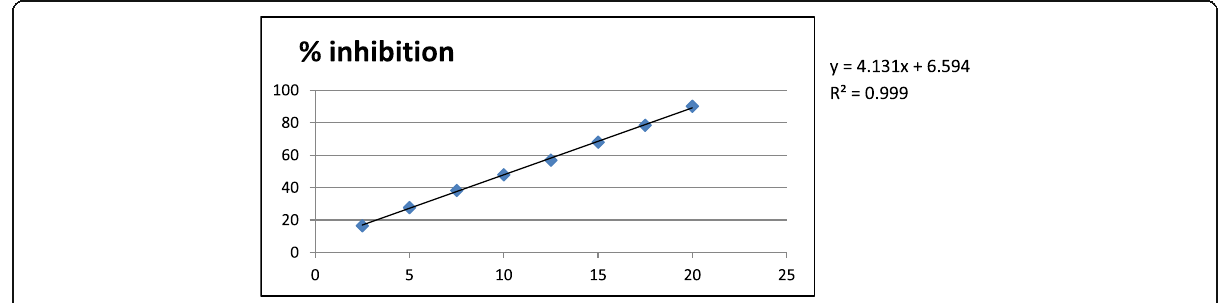
Fig. 3 Standard calibration curve of